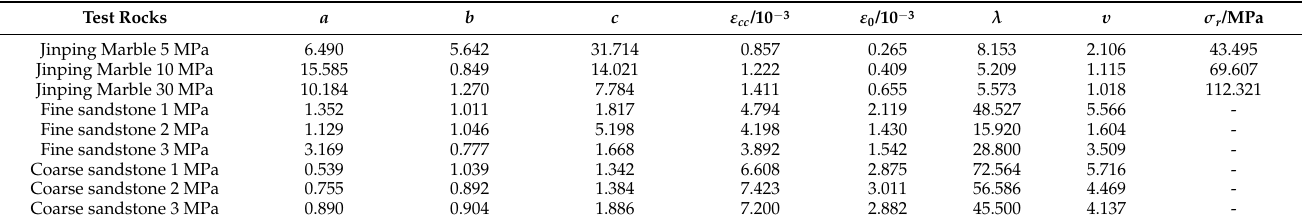
Table 2. Model parameters for triaxial tests.